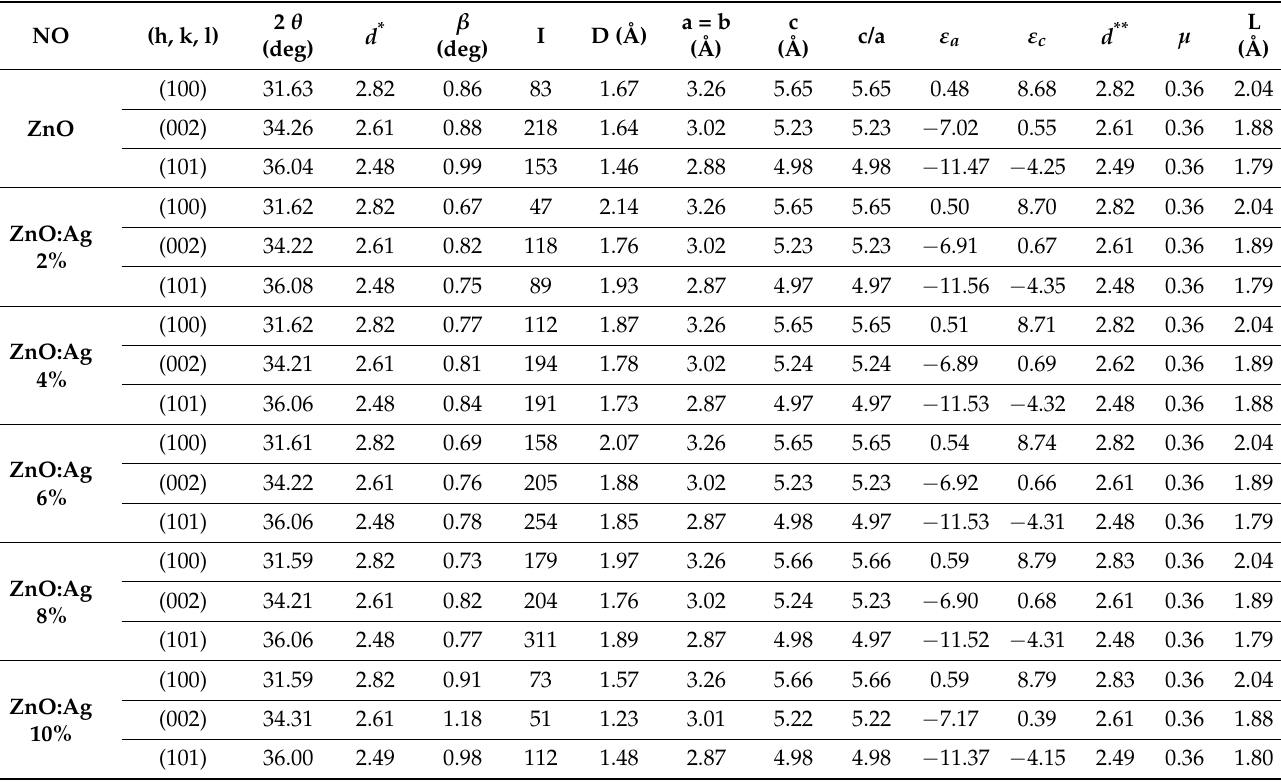
Table 1. Lattice parameters and structures of pure and Ag-doped ZnO submicron structures of the mean diffraction peak (100), (002), and